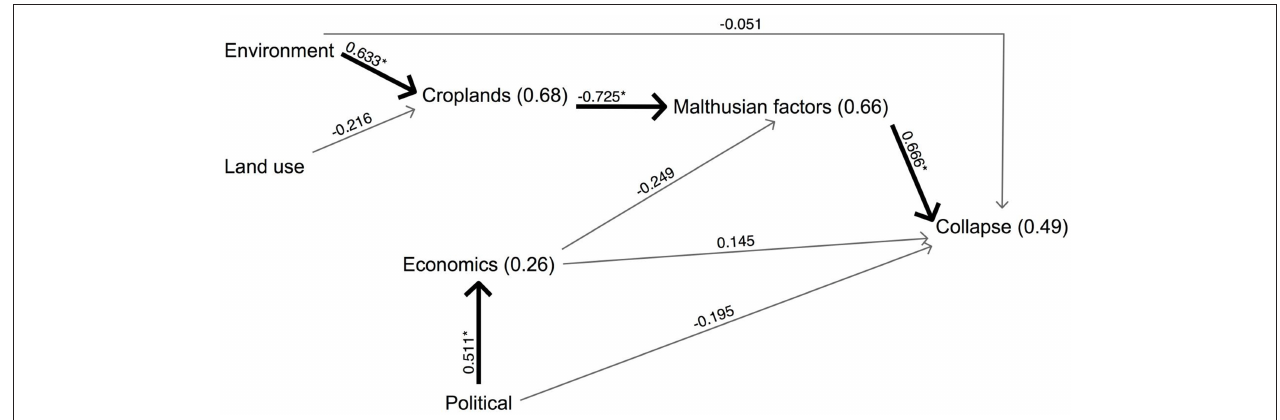
FIGURE 2 | Structural model path diagram. Beta coefficients are shown above arrows with significant paths marked with * symbols. Numbers in parenthesis are coefficients of